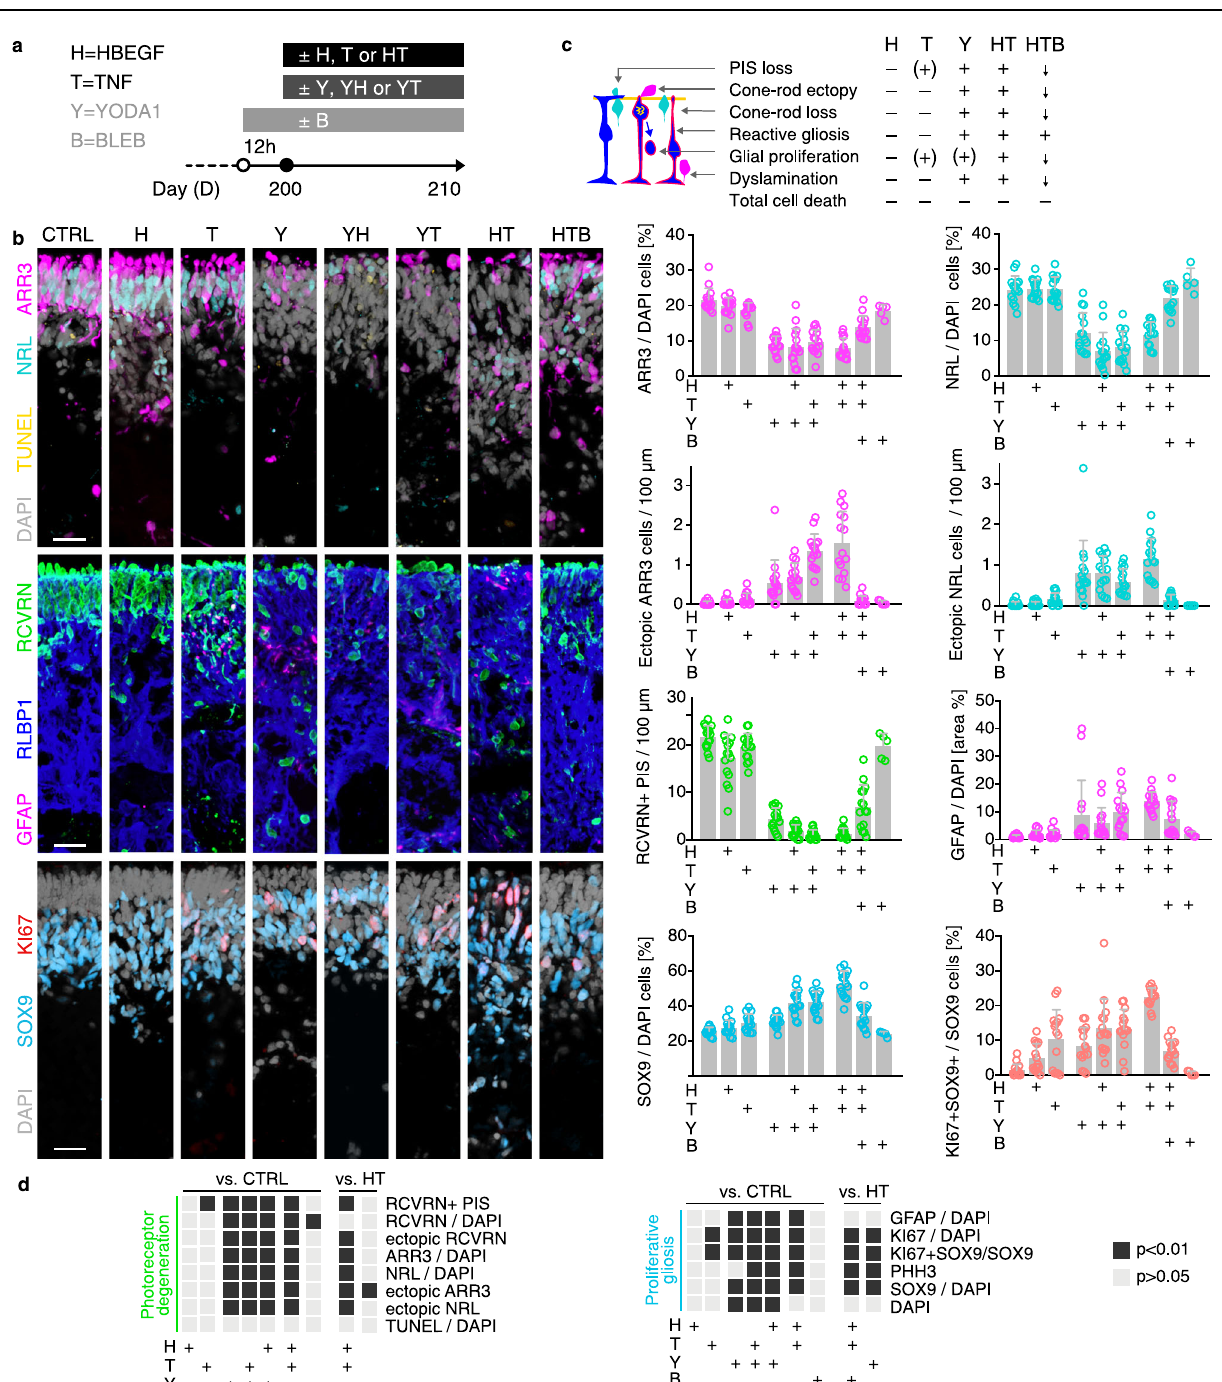
(seeSupplementaryFig.18c). c Schematicsummaryoftheeffectsofthetreatments on HROs: treatments induced either none ( – ), a minor ((+)), or a major (+) phe- notype,orareduction(arrows)inphenotypeseveritycomparedtoHT. d Graphical depictionofstatisticalanalysisofquantitativedatashownin( b ).Dark-graysquares depict signi fi cant changes ( P <0.01, one-way ANOVA with Tukey ’ s post hoc test) compared to control (CTRL) or HT-treated HROs, respectively. c Graphs: each circle represents 1 individual HRO ( n ) derived from N =3 independent experi- ments ( n ≥ 5/ N ). c Graphs (mean±SD) and ( d ) statistics over n . Types of treat- ments are indicated (+). Scale bars: b 50 μ m. See Supplementary Data 6. Source data are provided as a Source Data fi